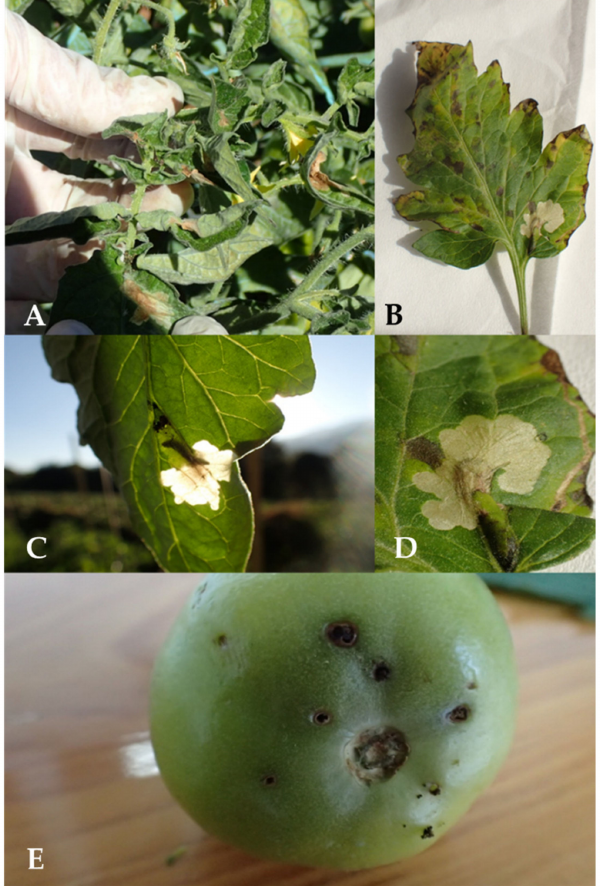
Figure 1. Typical damage on tomato leaves ( A – D ) and fruits ( E ) caused by the larvae of Tuta absoluta .